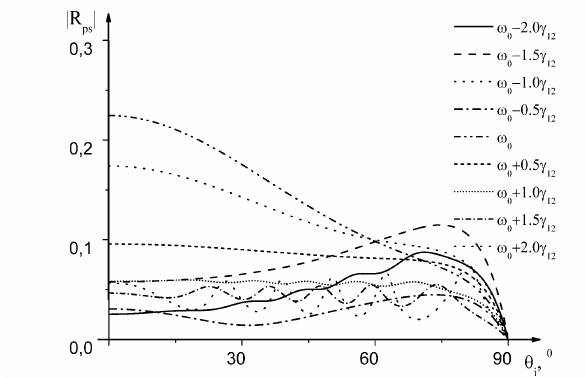
Fig. 3 . Angular dependence of the modulus of the amplitude reflection coefficient R sp in the vicinity of the resonant frequency